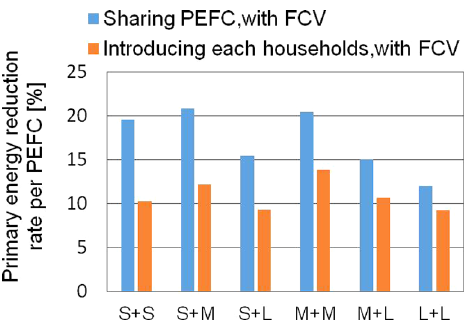
Fig. 13. Comparison of the case of sharing and introducing each other (based on the case with the PEFC system and